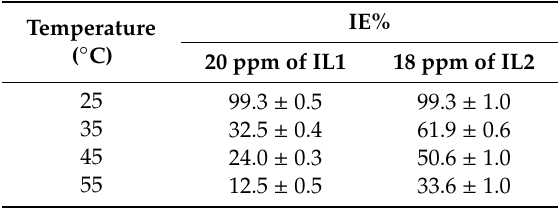
Table 2. Percent inhibition e ffi ciency (IE%) of the carbon steels directly coated with IL1 and